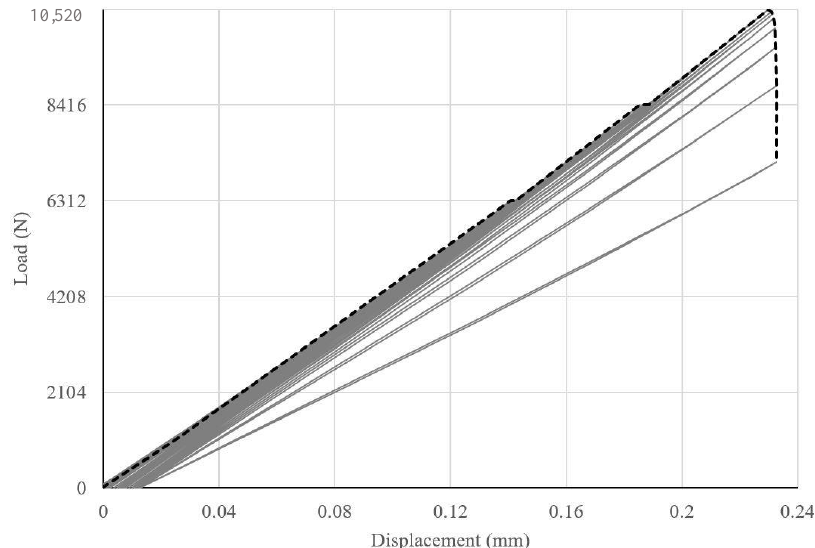
Figure 12. Load versus displacement curve of BFRP tie.